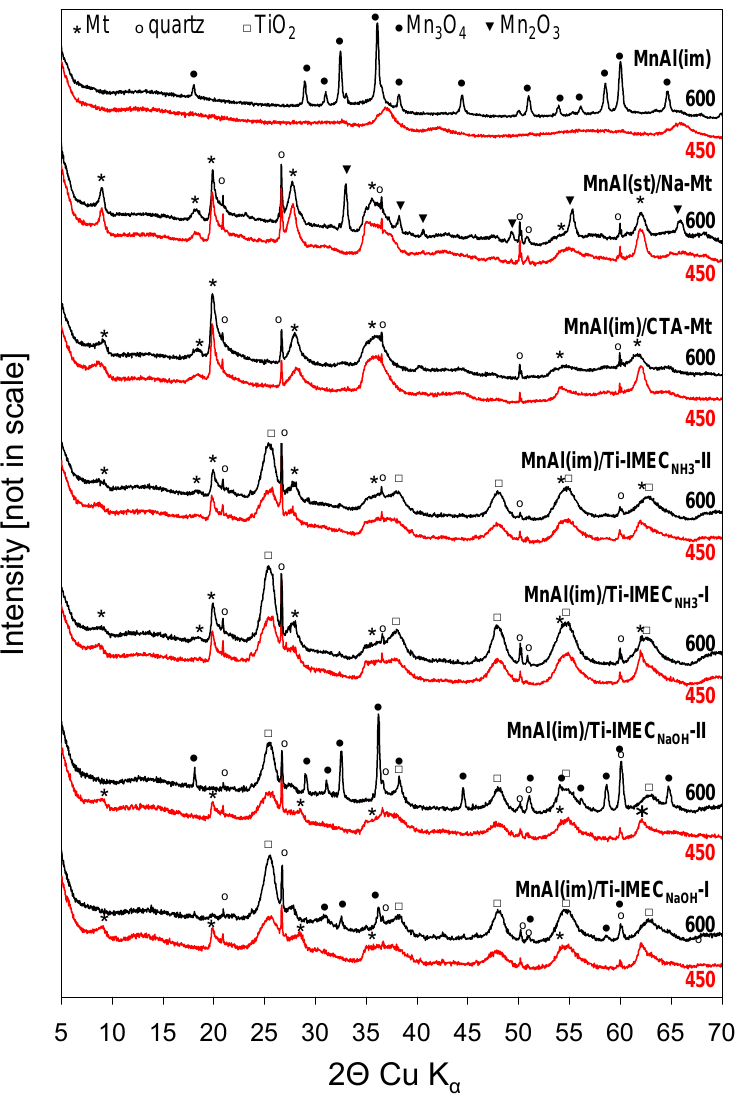
Figure 1. Powder X ‐ ray diffraction (XRD) patterns of investigated composites and the MnAl(im) Figure 1. Powder X-ray diffraction (XRD) patterns of investigated composites and the MnAl(im) active active phase calcined at 450 and 600 °C. phase calcined at 450 and 600 ◦